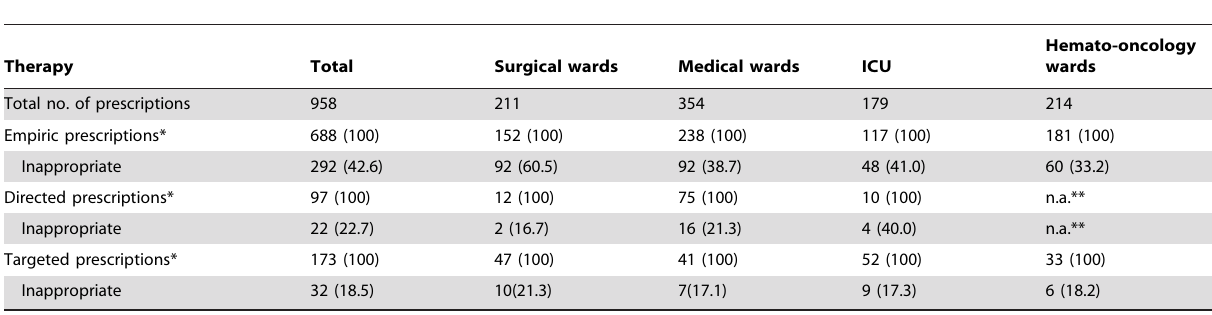
Table 5. Appropriateness of empiric, directed, and targeted